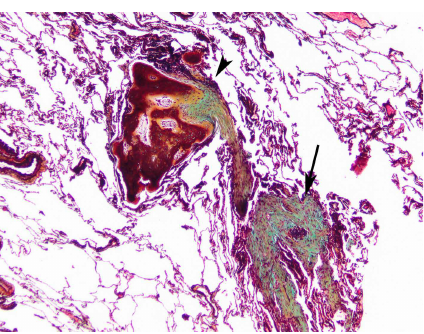
Figure 3: Areas of OP (arrow) with adjacent foci of cicatricial OP transitioning to DPO (arrowhead) (Movat stain;